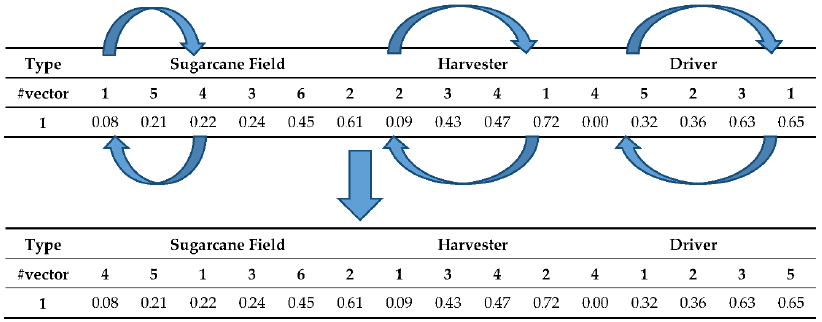
Figure 3. Results of swap method.